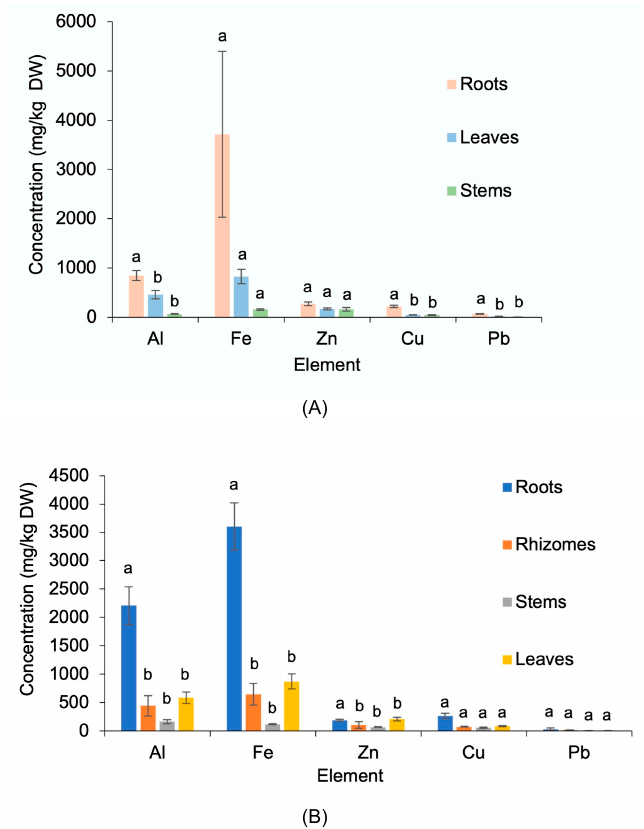
Figure 2. Element concentrations in plant tissues. ( A ) Element concentrations in plant tissues of A.